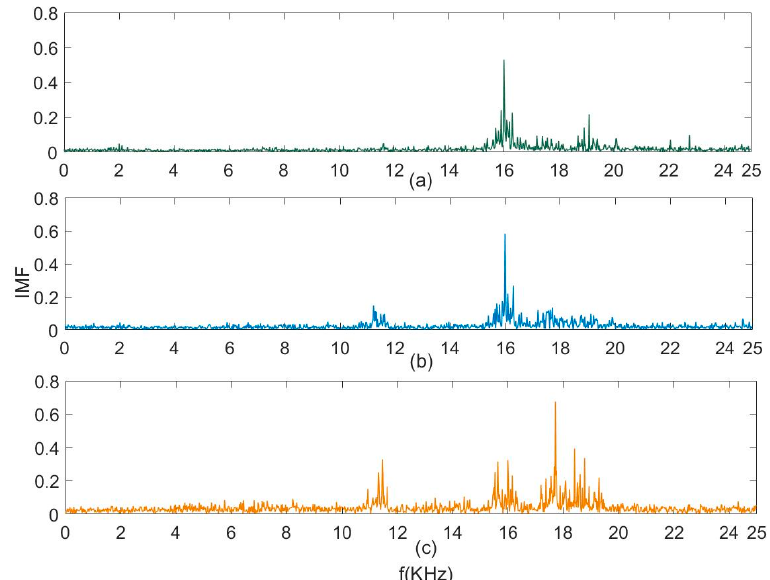
Figure 8. Frequency spectrum of vibration signal IMF1 at different times of milling experiment. ( a ) Frequency spectrum of vibration signal IMF1 at 85th milling experiment; ( b ) Frequency spectrum of vibration signal IMF1 at 185th milling experiment; ( c ) Frequency spectrum of vibration signal IMF1 at 285th milling experiment.